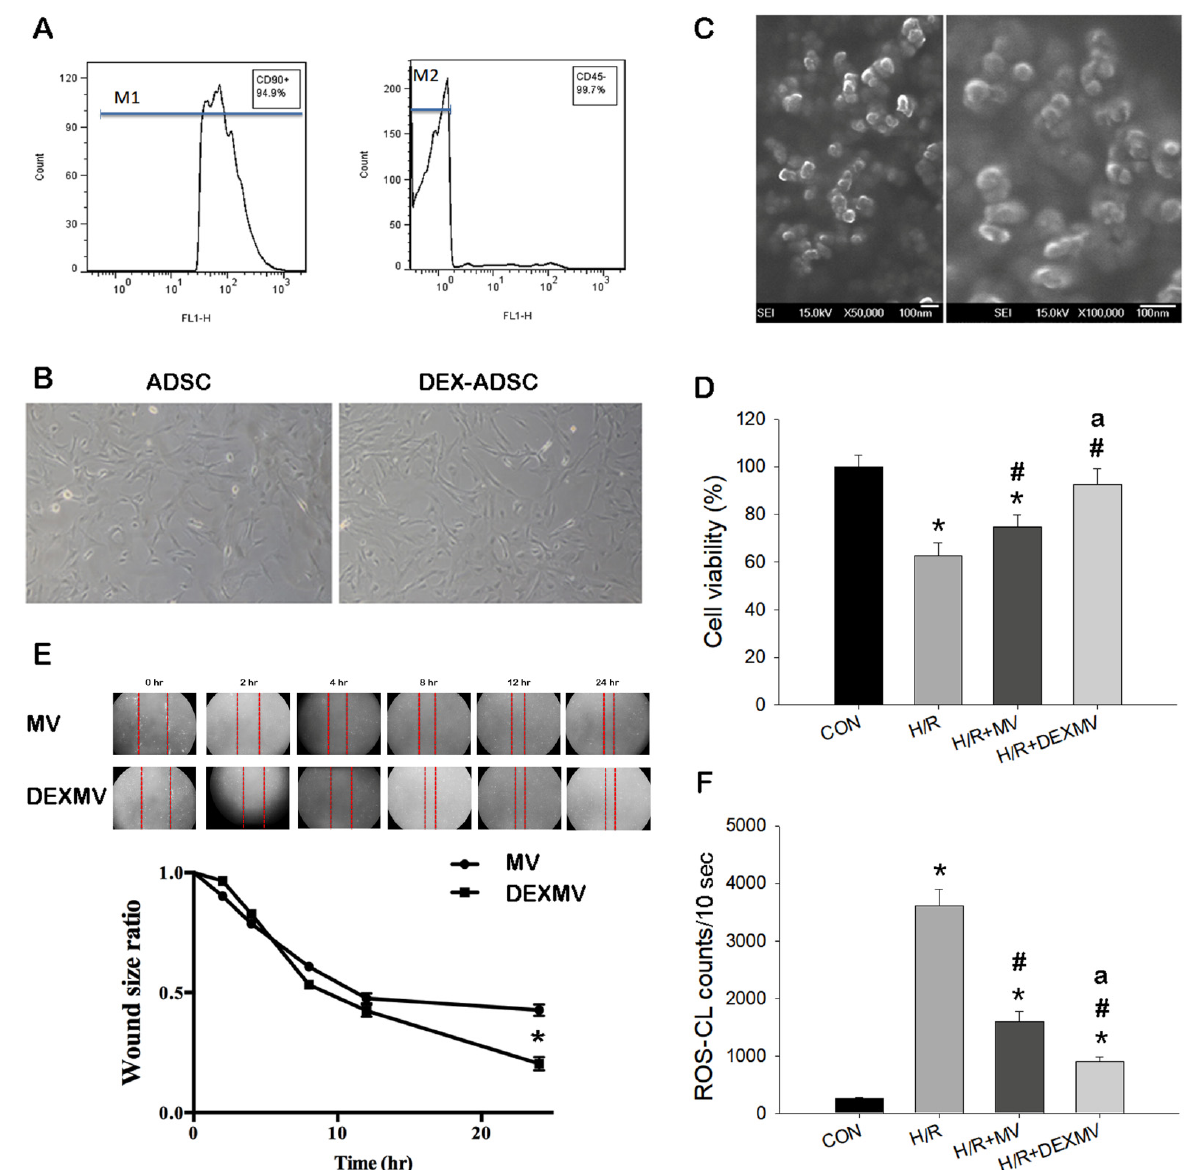
Figure 1. Identification of purified ADSC with CD90-positive characterization and CD45-negative characterization in the P4 ADSC by flow cytometry ( A ). The morphology in control ADSC (ADSC) and DEX-treated ADSC (DEX-ADSC) (Magnification Scale: 50 μ m) in 80% confluency is similar in our result ( B ). Cells displayed fibroblast-like morphology (long and thin) under phase-contrast microscope. Nanoparticle size of MV is amplified 50,000 times (left) and 100,000 times (right), existing in ADSC culture medium ( C ). Effect of MVs and DEX-MVs on wound healing of NRK-52E cells in different time courses ( D ). DEX-MVs significantly decreased wound size ratio as compared to MVs. NRK-52E cells in response to H/R significantly decreased viability ( E ) and increased ROS ( F ) vs. CON. MVs or DEX-MVs significantly improved cell viability and reduced ROS counts vs. H/R group. DEX-MVs were more efficient than MVs in increase in cell viability and decrease in ROS counts. n = 6 in each experiment. ADSC, adipose stem cell; DEX, dexmedetomidine; MV, microvesicle; H/R, hypoxia/reoxygenation; ROS, reactive oxygen species. * p < 0.05 vs. CON. # p < 0.05 vs. H/R. a p < 0.05 vs. MV.